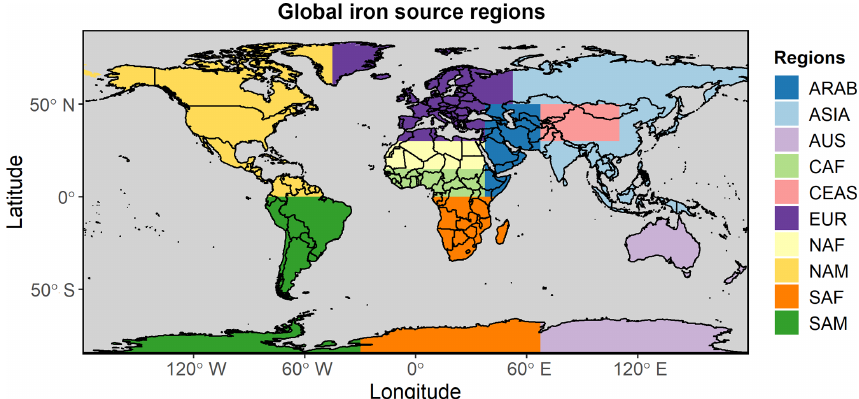
Figure 1. Major iron aerosol emission source